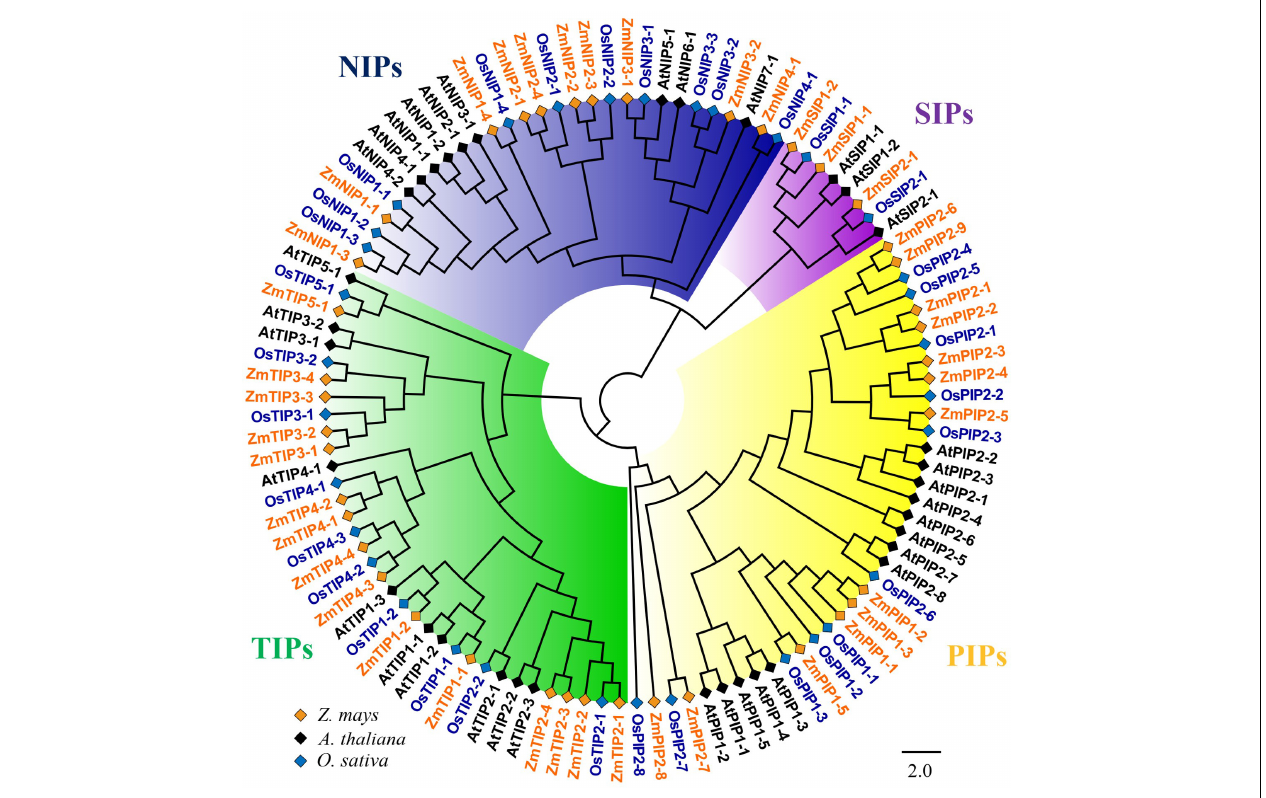
FIGURE 1 | Phylogenetic analysis of 109 aquaporin proteins from Z. mays (Zm, indicated in orange), A. thaliana (At, indicated in black), and O. sativa (Os, indicated in blue). The ZmAQPs clustered into four different subfamilies (PIPs, TIPs, NIPs, and SIPs), with the corresponding OsAQP and AtAQP subfamilies. Each AQP subfamily is highlighted with a specific background color. PIPs, TIPs, NIPs, and SIPs are indicated in yellow, green, blue and purple, respectively. Multi-species protein sequence alignment was performed using Clustal W software. The phylogenetic tree was constructed using MEGA X based on the NJ method and further improved using the FigTree (v1.4.4)